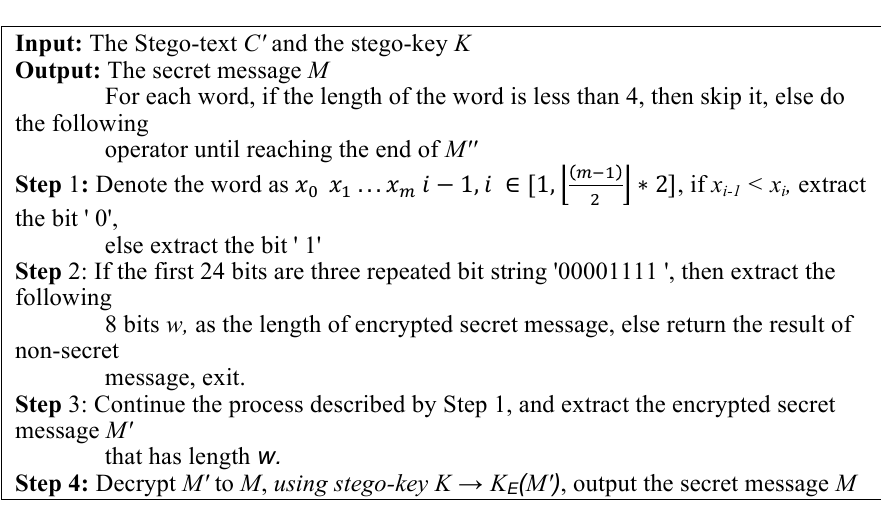
Fig. 2. Extraction